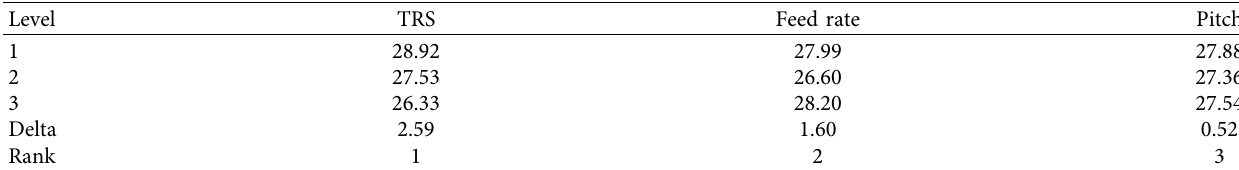
Table 6: Response for S / N ratios of